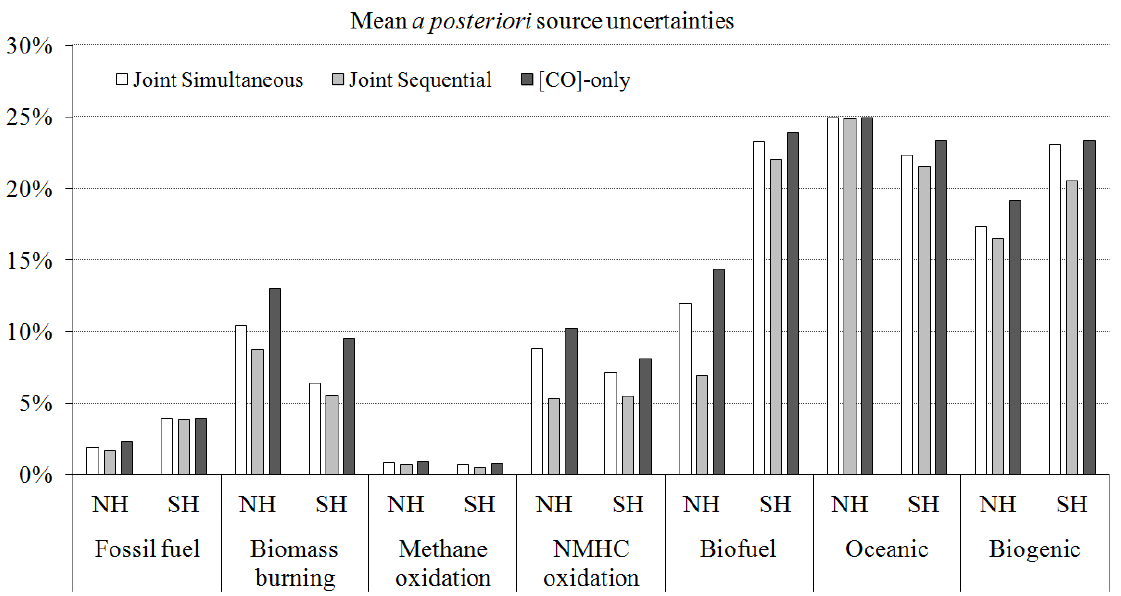
Figure 10. Comparison of a posteriori uncertainty of three different inversion schemes: CO-only, sequential and simultaneous